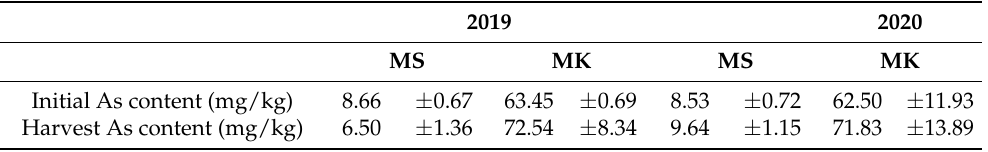
Table 1. The total As content in soil of experimental sites at the initial and harvesting stages.